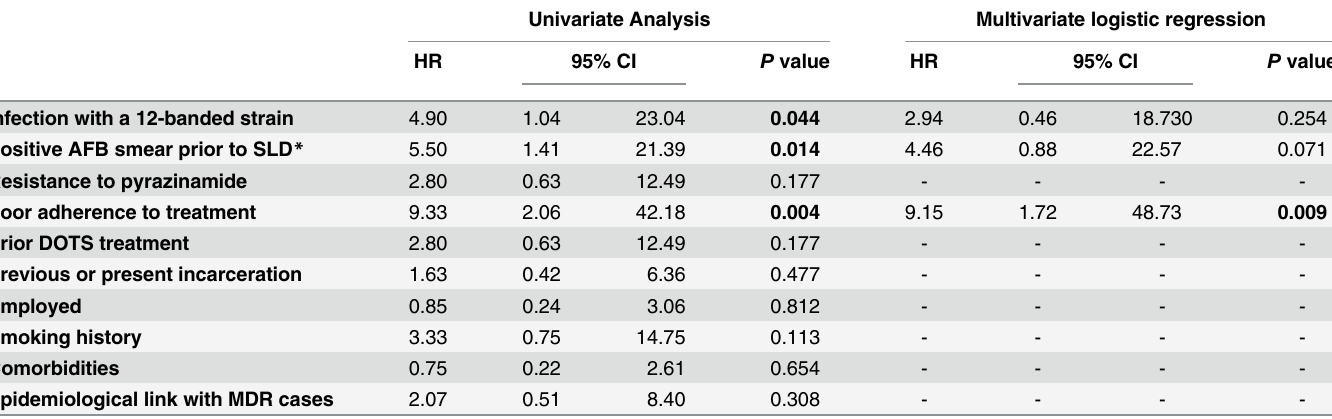
Table 3. Predictors of unfavorable outcomes for the MDR-TB outbreak patients that had received a 2-year second line anti-TB